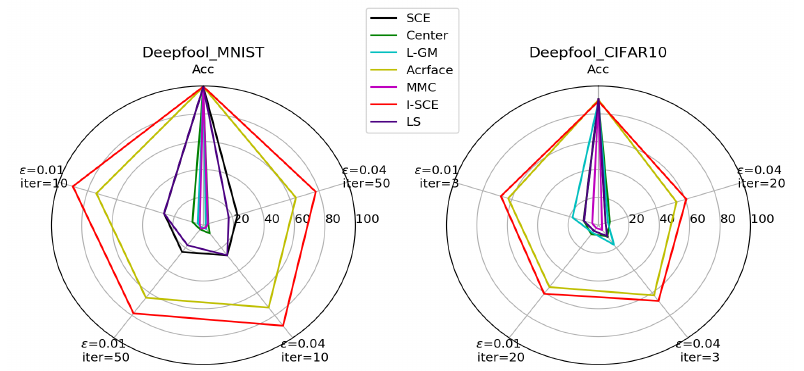
Figure 8. Classification accuracy (%) under Deepfool